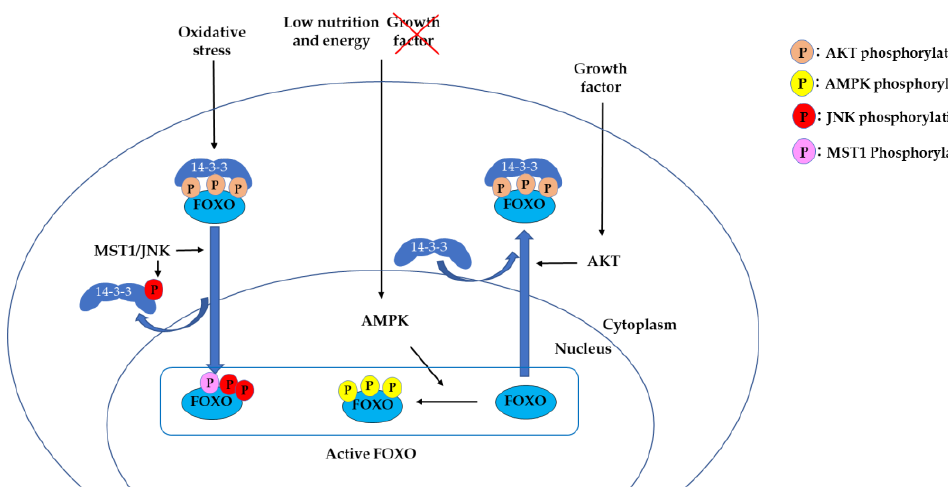
Figure 1. Transcriptional activity of forkhead box (FOXO) is regulated by the AKT, AMP-activated protein kinase (AMPK), and mammalian Ste20-like kinase/c-Jun N-terminal protein kinase (MST/JNK) pathways. In response to growth factor stimuli, AKT phosphorylates FOXO, leading to 14-3-3 binding and translocation of FOXO to the cytoplasm. In response to a low energy condition, AMPK phosphorylates FOXO in the nucleus and activates transcription. In response to oxidative stress, MST1/JNK phosphorylates FOXO, leading to nuclear translocation.